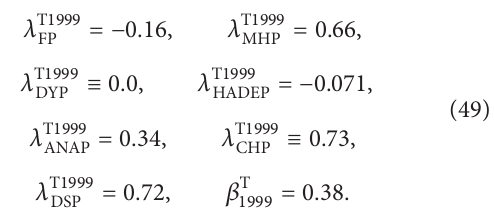
Figure 7: Party positions and voter distribution in the 1999 Turkish election.